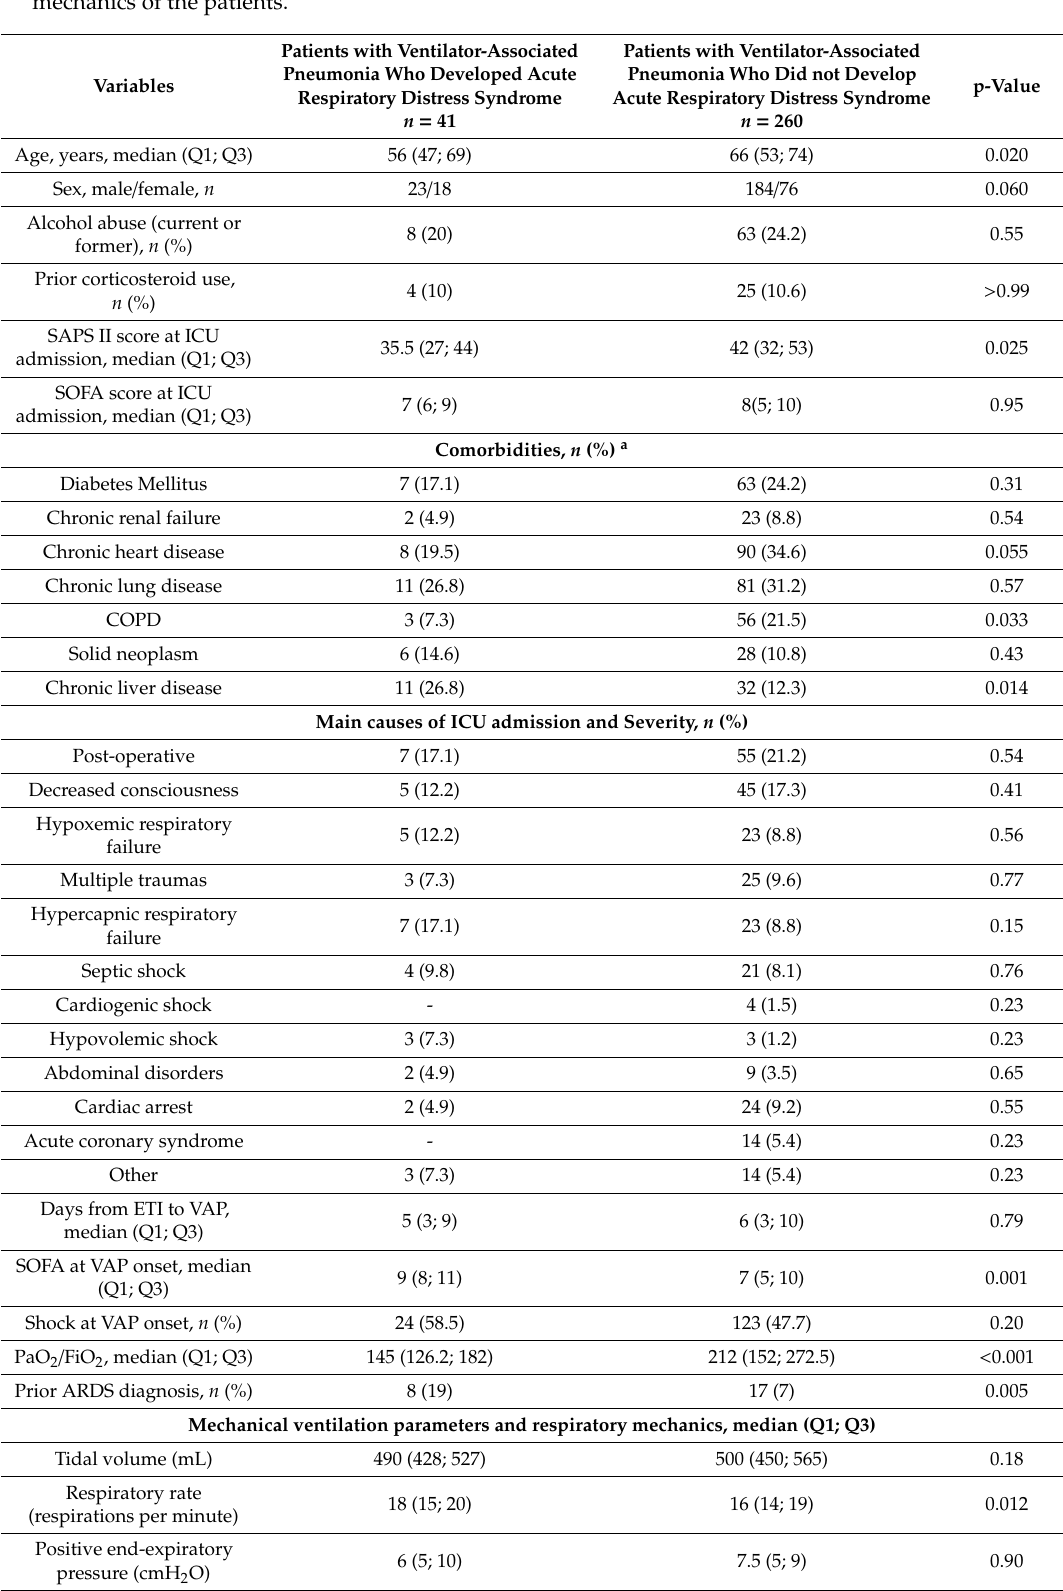
Table 1. Baseline characteristics, main causes of intensive care unit admission; severity and respiratory mechanics of the